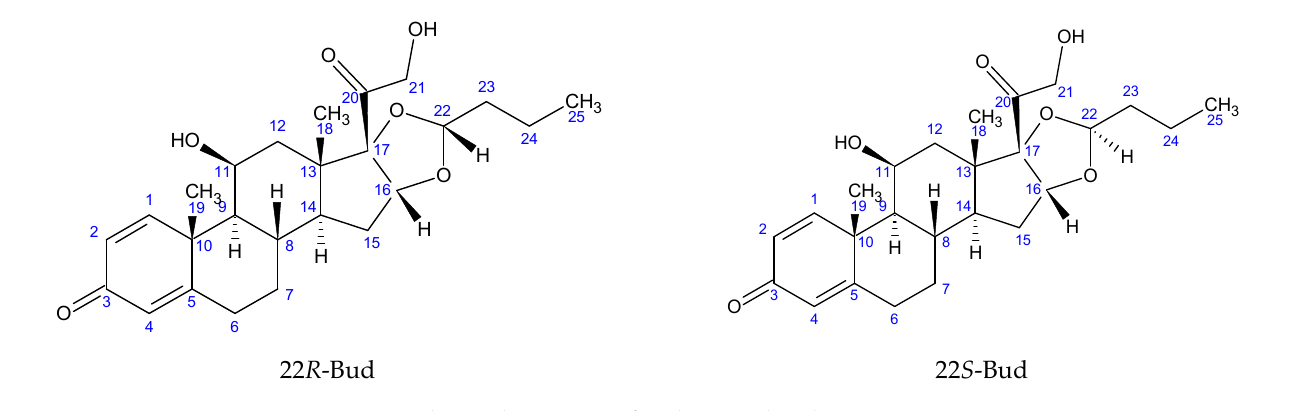
Figure 1. Chemical structures of Bud-22 R and Bud-22 S .